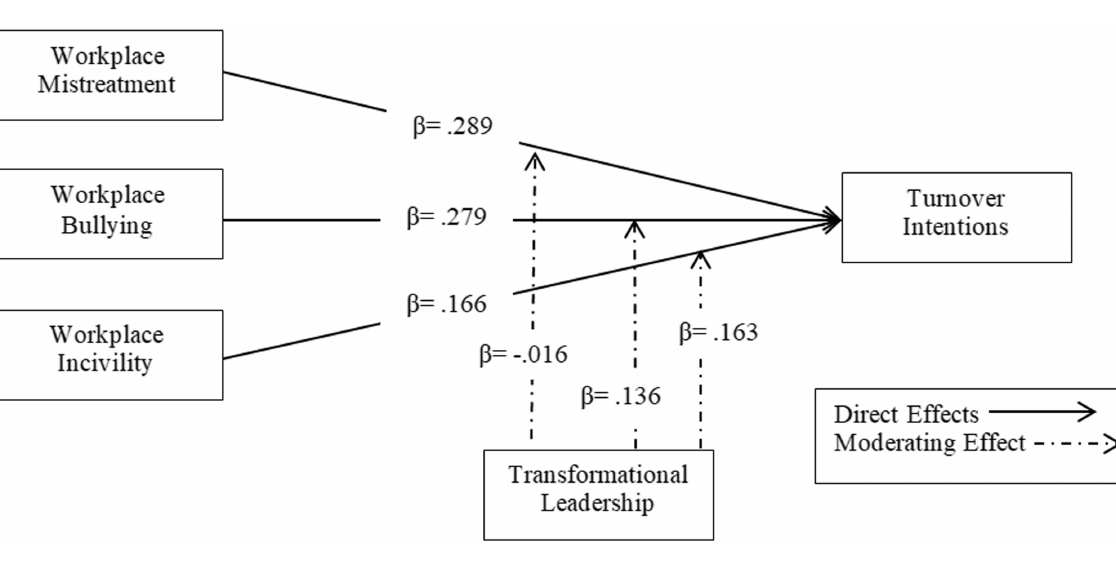
FIGURE 3 Structural equation modeling (SEM) model estimation.